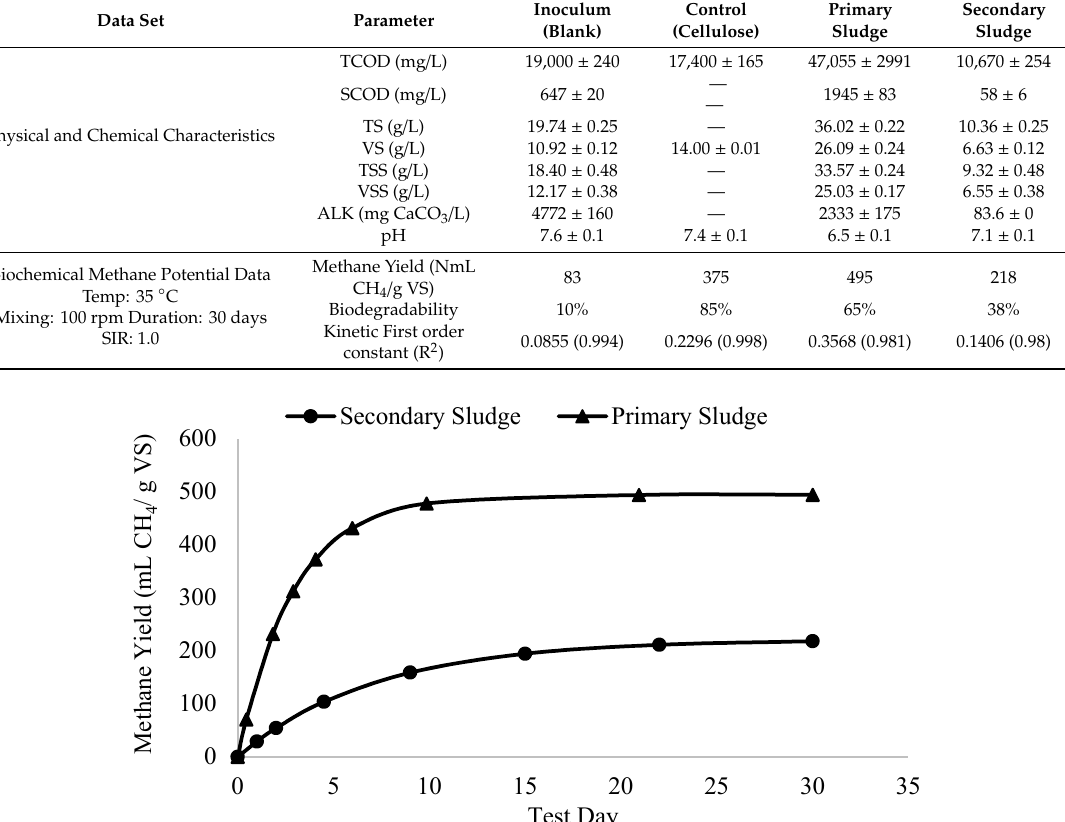
Figure 9. Example final report methane yield graph of primary and secondary sludge from the GWWTP.